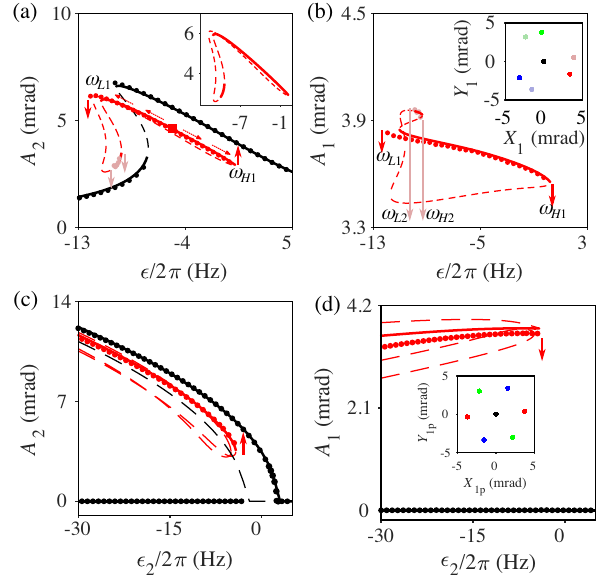
FIG. 3. (a) Dependence of the vibration amplitude of mode 2 on the frequency detune of the resonant drive. Black circles are the measured amplitude of mode 2 when mode 1 is in the zero- amplitude state. Light and dark red circles represent the measured amplitude of mode 2 when mode 1 is in a period-tripled state. Solid lines are stable states calculated with Eq. (3). Dashed lines are unstable states. The left and right light red arrows mark ω L 2 and ω H 2 , respectively. Inset: For clarity, calculated amplitudes are shown without measurement data. (b) Vibration amplitude of mode 1. Inset: two sets of period-tripled states with different amplitudes plotted in the phase space. (c) The vibration amplitude of mode 2 when its eigenfrequency is parametrically modulated near 2 ω 2 . (d) The corresponding vibration amplitude of mode 1. Inset: six coexisting states with identical amplitude but with phases differing by π = 3 in phase